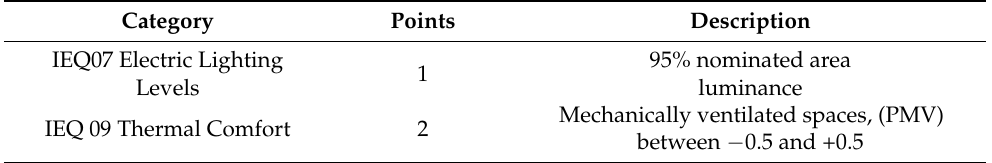
Table 3. Project scorecard EMS College—IEQ